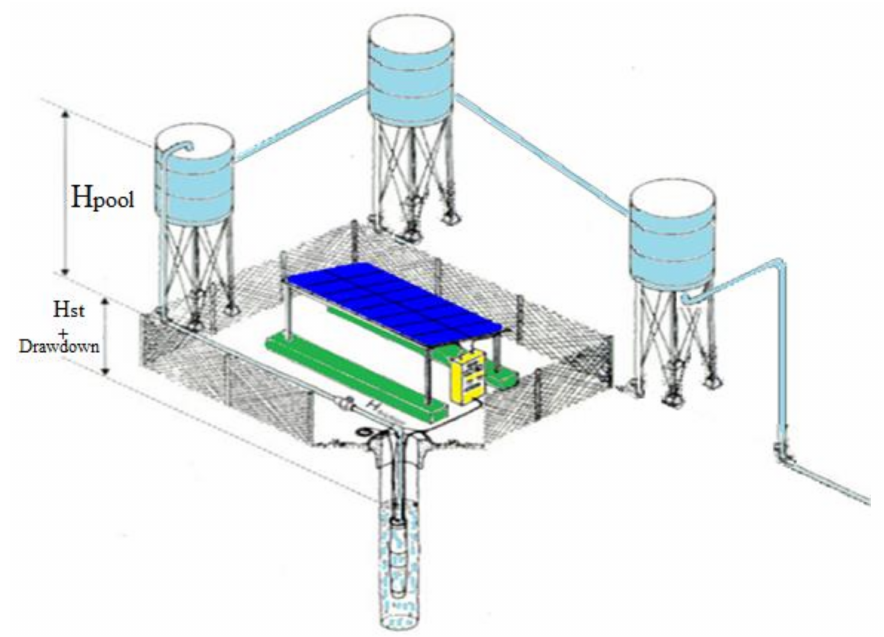
Figure 1. The concept of the PV pumping system for irrigation application (original